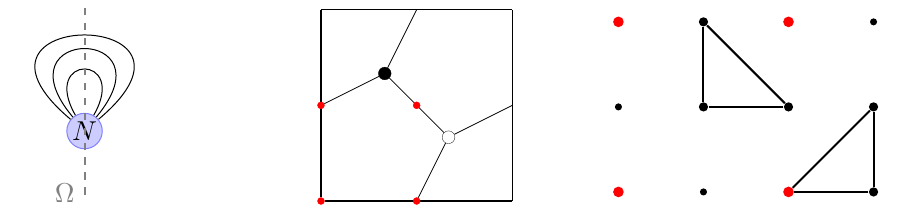
Figure 7. The unoriented quiver (left) and the dimer (center) of C 3 , while the unoriented toric diagram (right) with the two orientifolds (cid:10)3 and